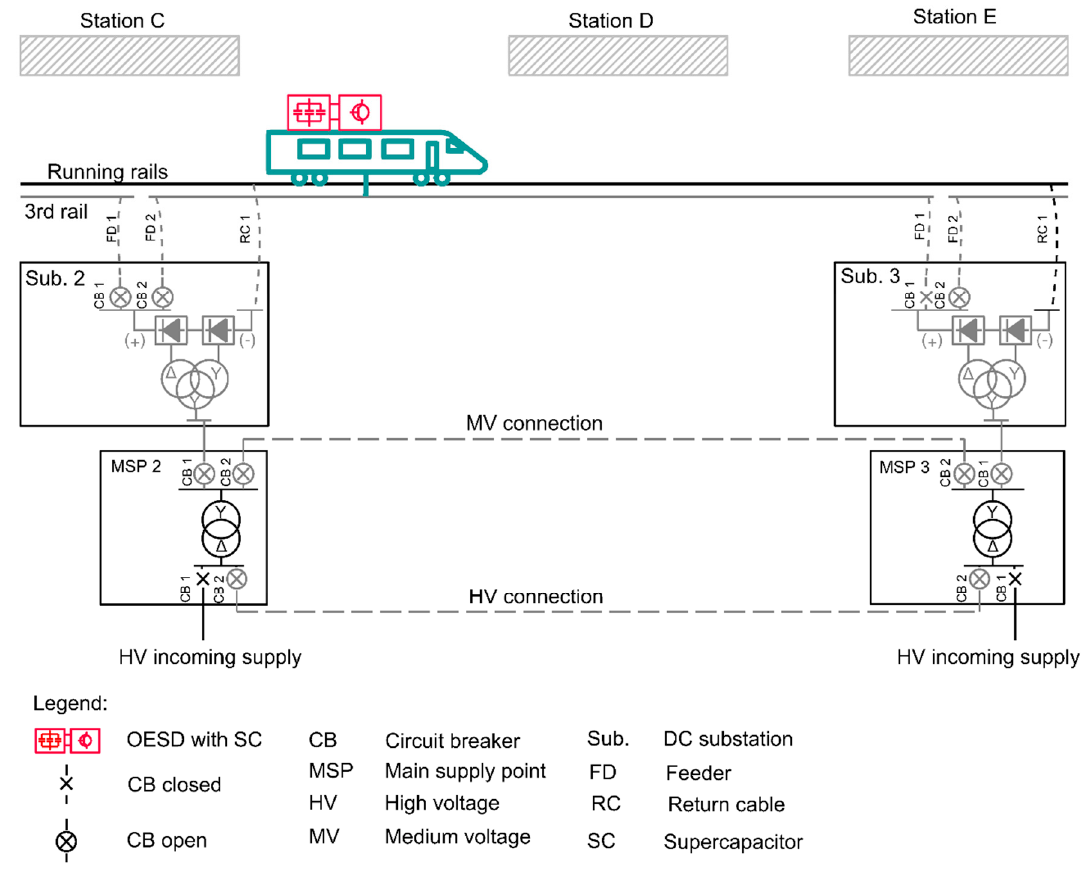
Figure 10. Emergency feeding from OESD.